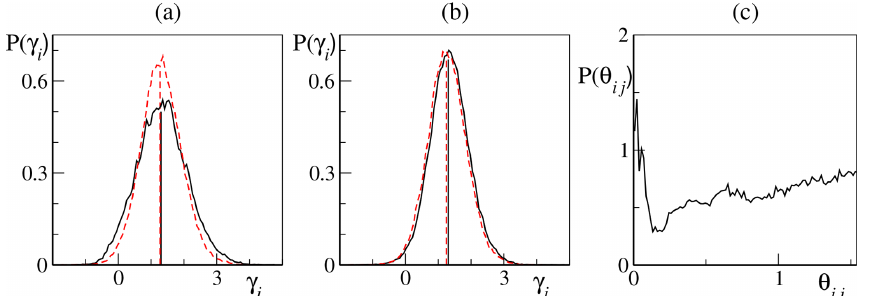
Figure 7. (a–b) Probability distribution of the finite-time LEs (26) for two nearby LEs belonging to the slow bundle. We show results for the 92nd (black solid line) and 93rd (red dashed line) LEs which, in the absence of tangent-space coupling (the restricted setup; see text), belong, respectively, to the λ X and λ Y restricted spectra. (a) Finite-time LEs fluctuations in the restricted case. The vertical lines mark the mean = 1 . 30 and λ Y = 1 . 275 (indices refer to the full spectrum position, and they correspond to the 5th and 88th, respectively, LE in values λ X 92 93 the X and Y restricted spectra). (b) Finite-time LEs fluctuations in the fully coupled case. The vertical lines mark the mean values λ 92 = 1 . 31 and λ 93 = 1 . 25. (c) Probability distribution of the angle θ ij (see Eq. 27) between the two corresponding CLVs in the fully coupled case. All simulations have been performed for K = 36, J = 10, b = 10 and h = 1 / 16. We have fixed the following in all panels: K = 36 and J = 10.